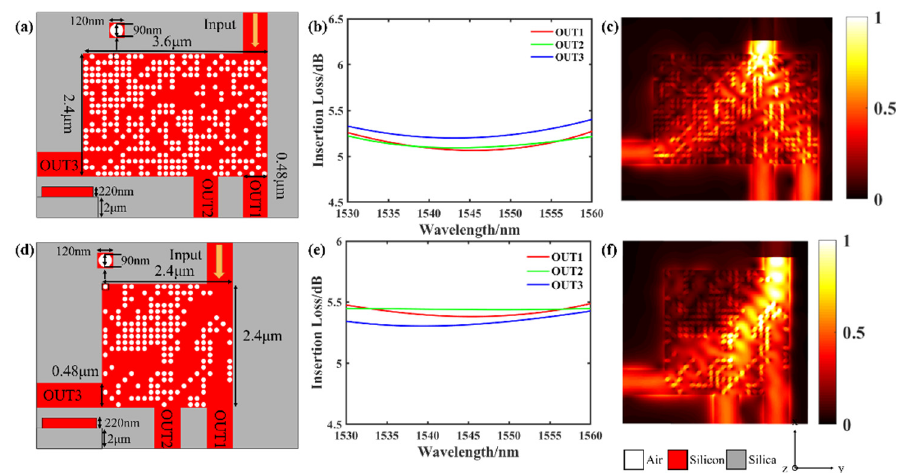
Figure 3. The simulated results of LLDDPS and LDDPS. ( a , d ) are the final simulation structure. ( b , e ) are the IL of each output waveguide of LLDDPS and LDDPS, respectively. ( c , f ) are the optical field distribution.